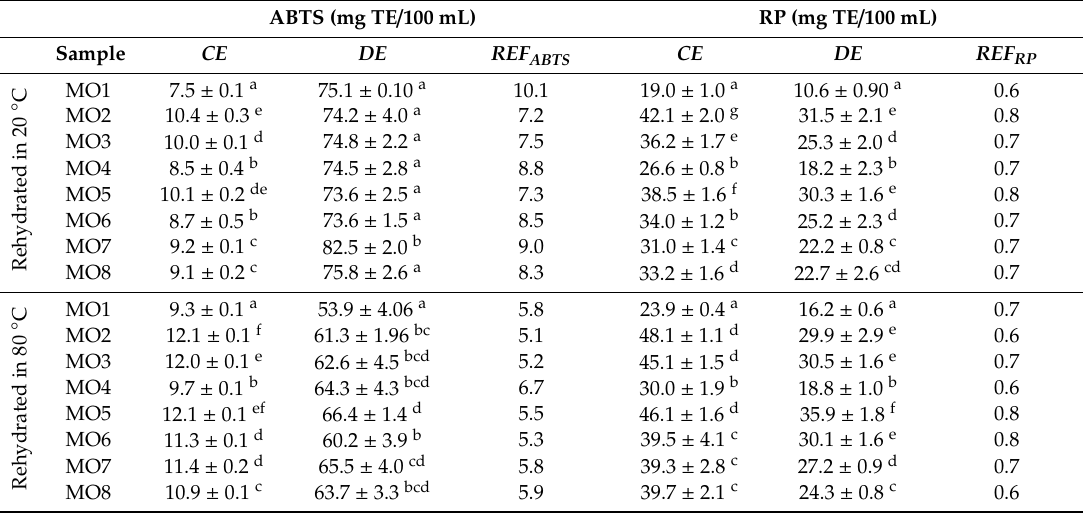
Table 3. Antioxidant properties of beverages rehydrated in 20 ◦ C and 80 ◦